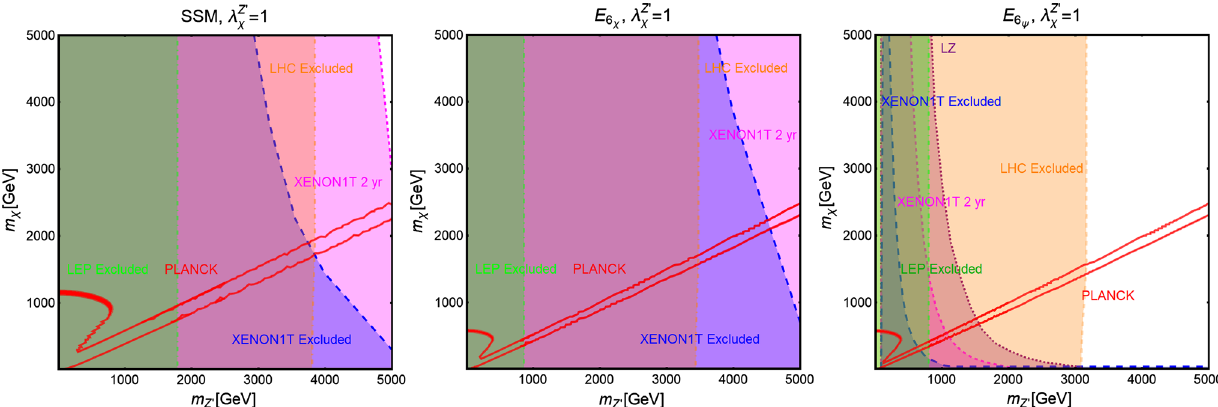
DM DD while the magenta and purple regions are currently allowed but within the sensitivity of XENON1T (assuming 2 years of exposure) and LZ, respectively. Finally, the green and orange regions represent the exclusions from dilepton searches by the LEP/Tevatron and